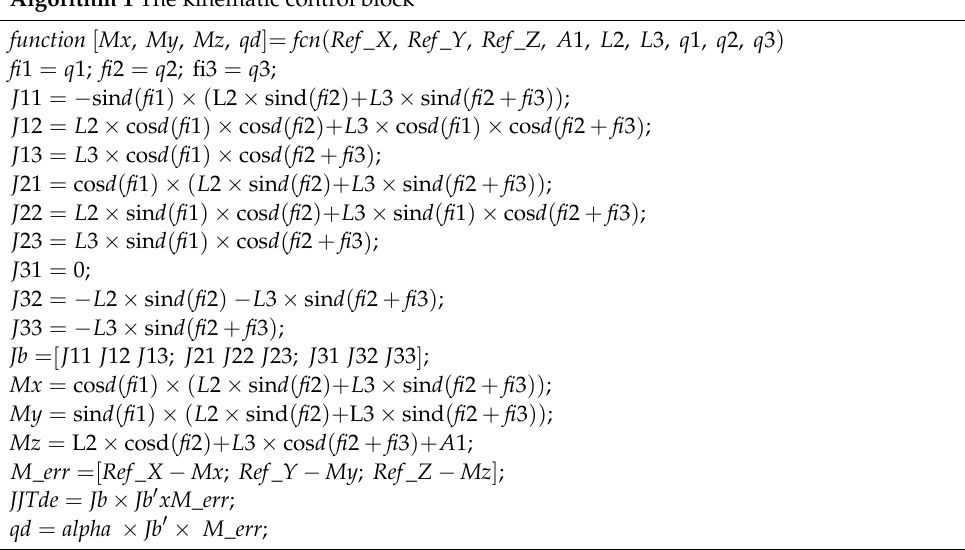
Figure 13. The sliding control diagram made in MATLAB Simulink. Algorithm 1 The kinematic control